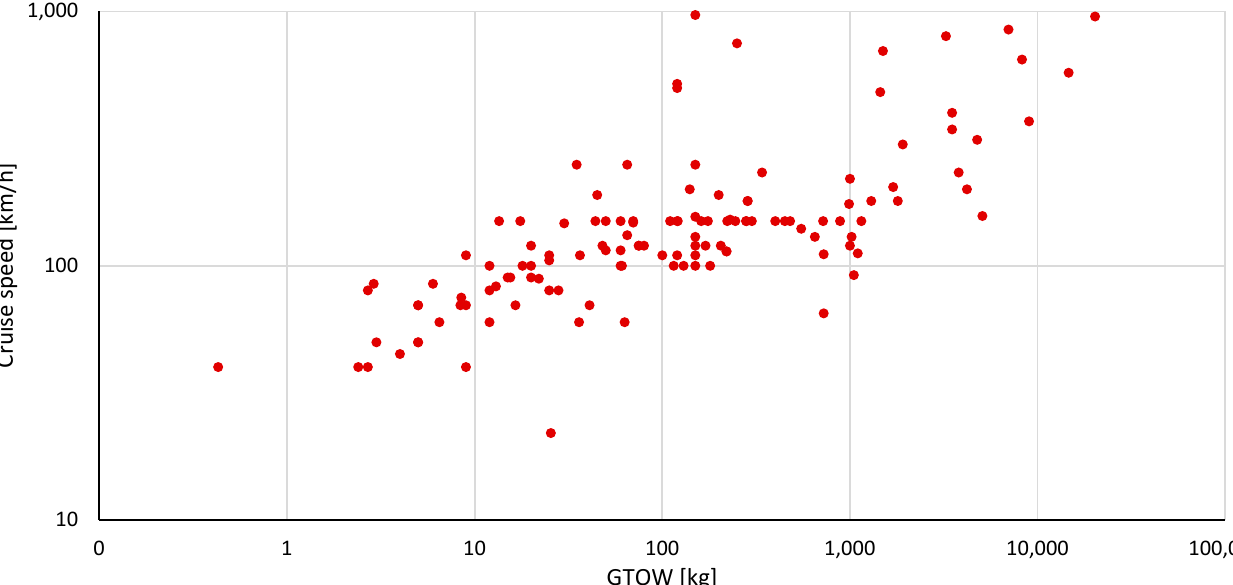
Figure 21. Cruise speed as a function of GTOW with respect to NATO classi fi cation. The color code is identical to the one described in Figure 6. Table 9. Statistical data regarding the trend fi tt ing for the cruise speed vs. GTOW plots. R 2